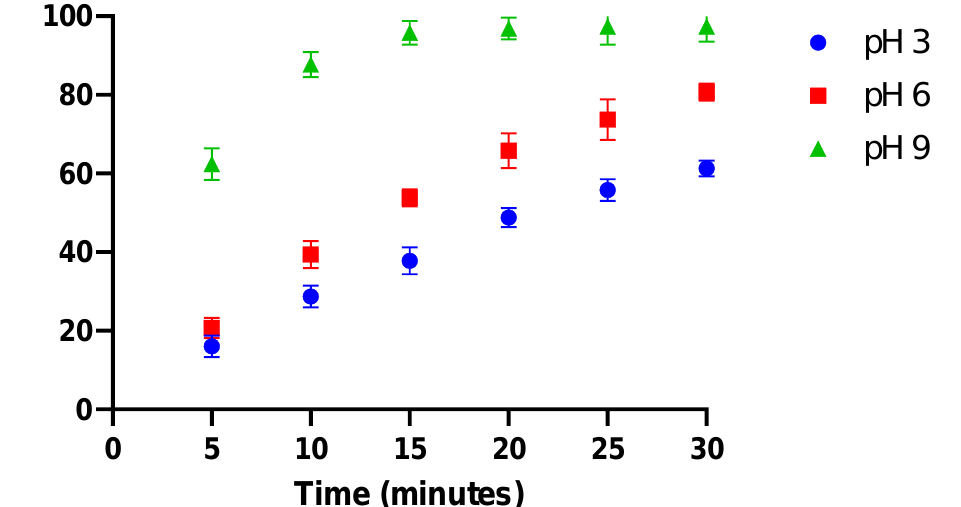
Figure 3. Percentage of degradation product formed under the simulated light condition (DP1) as a function of time and pH condition.